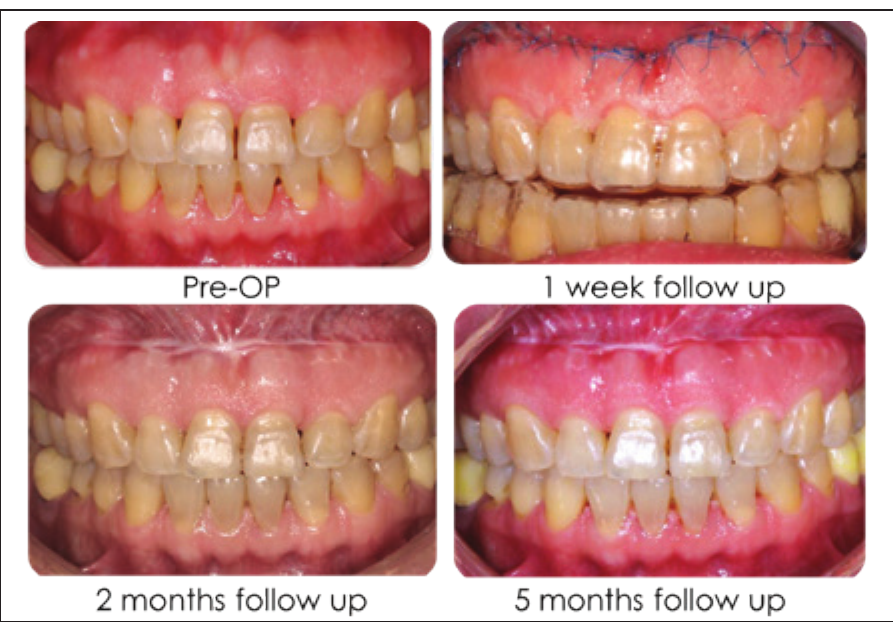
Figure 8. At the five-month follow-up, scar tissues were noted over the lip repositioning incision wound and soft tissue condition was stable.